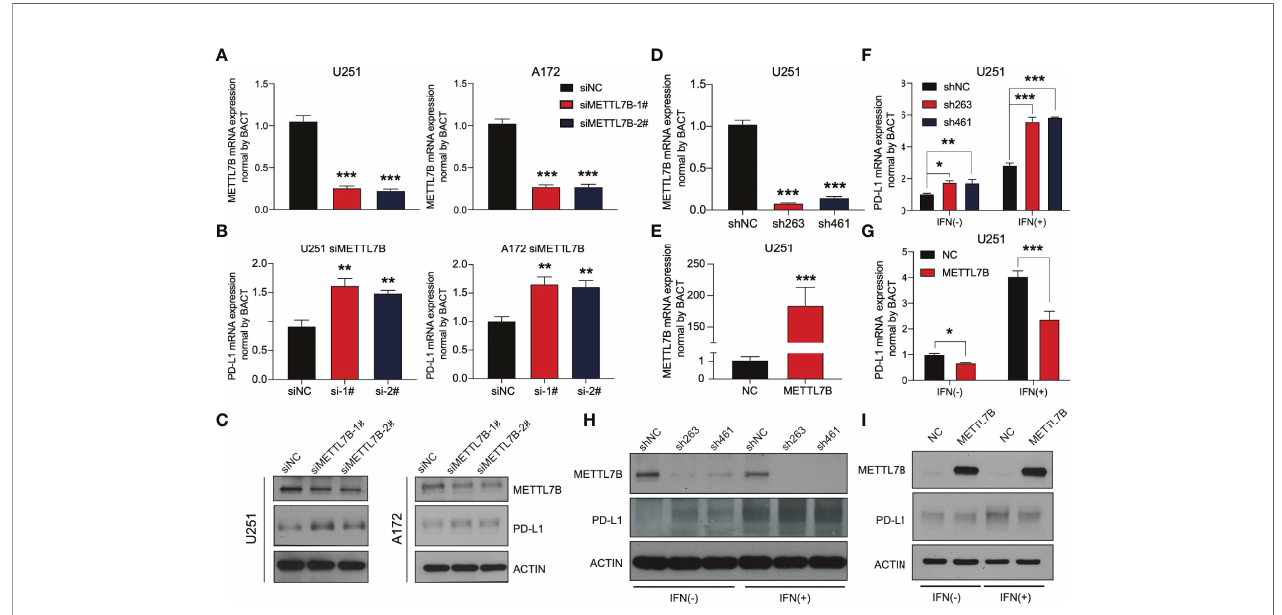
FIGURE 8 | METTL7B affects the expression of PD-L1 in glioma. qRT – PCR showed that the METTL7B siRNAs in (A) U251 and (B) A172 cells could signi fi cantly downregulate METTL7B at the transcriptional level. (C) The expression of METTL7B and PD-L1 in U251 siMETTL7B and A172 siMETTL7B cells was detected by Western blot. (D) The expression of METTL7B mRNA in the U251 shMETTL7B cell line was detected by qRT – PCR. (E) The expression of METTL7B mRNA in U251 METTL7B-overexpressing cells was detected by qRT – PCR. The expression of PD-L1 in (F) U251 shMETTL7B and (G) overexpression cell lines in the presence and absence of interferon-gamma (80 ng/mL) was detected by qRT – PCR. The expression of PD-L1 in (H) U251 shMETTL7B and (I) overexpression cell lines in the presence and absence of interferon-gamma (80 ng/mL) was detected by Western blot. *p < 0.05, **p < 0.01, ***p <